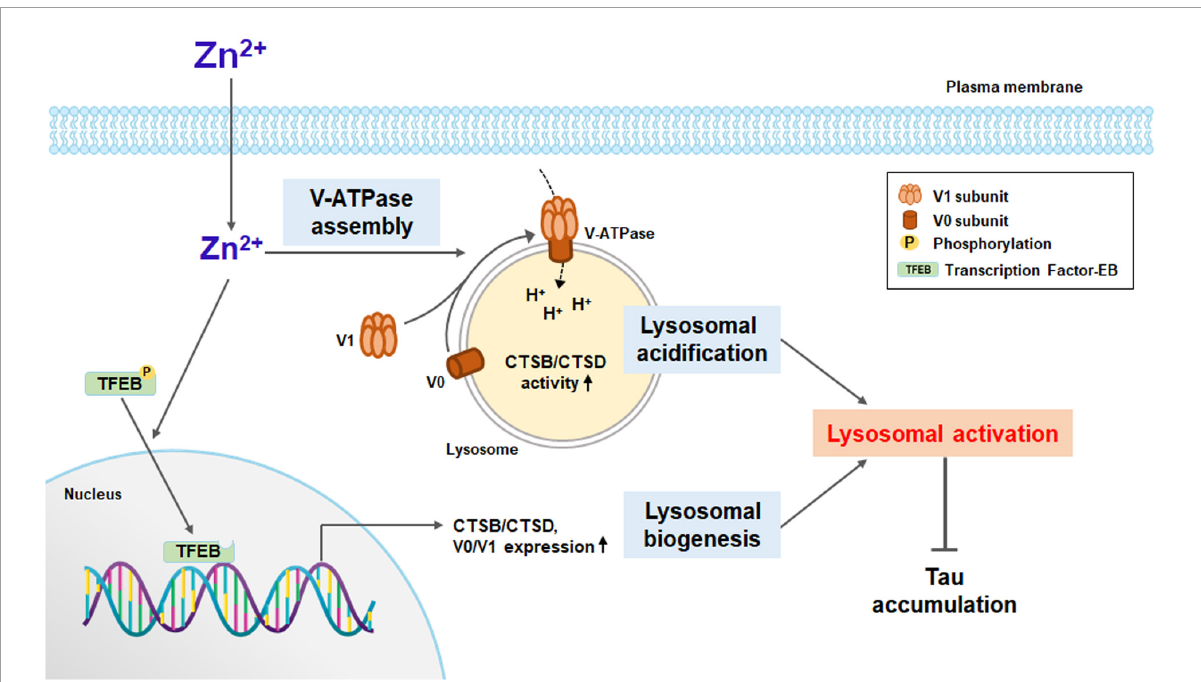
FIGURE8 A diagram for zinc-induced lysosomal activation. Zinc under sub-lethal concentration contributes to lysosomal activation. Zinc promotes the function of V-ATPase by rapidly increasing the assembly of the V1 subunit and the V0 subunit on the lysosomal membrane. As a result, lysosomal acidification is improved, and the activity of proteolytic enzymes such as CTSB and CTSD is increased. Zinc also promotes the dephosphorylation of TFEB and its translocation to the nucleus. TFEB in the nucleus activates the expression of lysosomal degrading enzymes, including CTSB and CTSD, and the proteins constituting V-ATPase such as V0D1 and V1B2. Enhanced lysosomal acidification and biogenesis induce strong lysosomal activation, which can significantly contribute to the degradation of protein aggregates, especially when the autophagic flux is